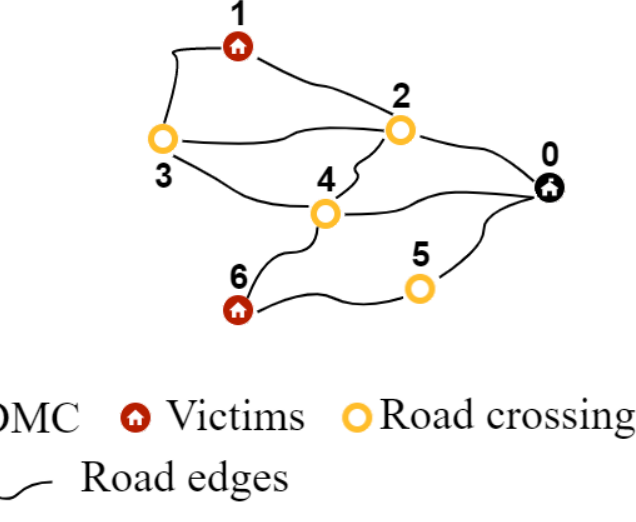
Figure 1. Known road network.